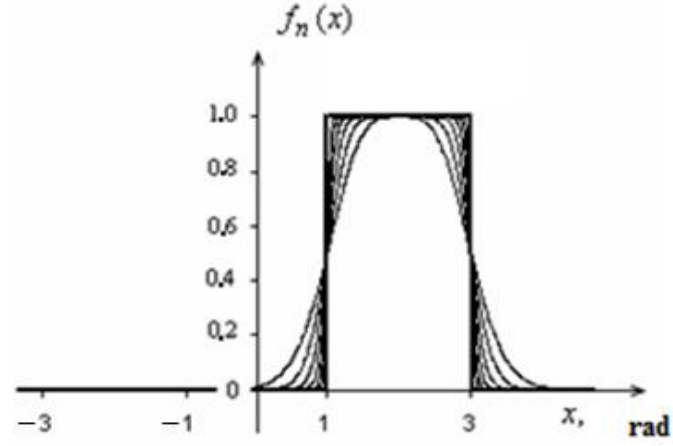
Figure 13. An example of a stepped approximation of nonperiodic functions.